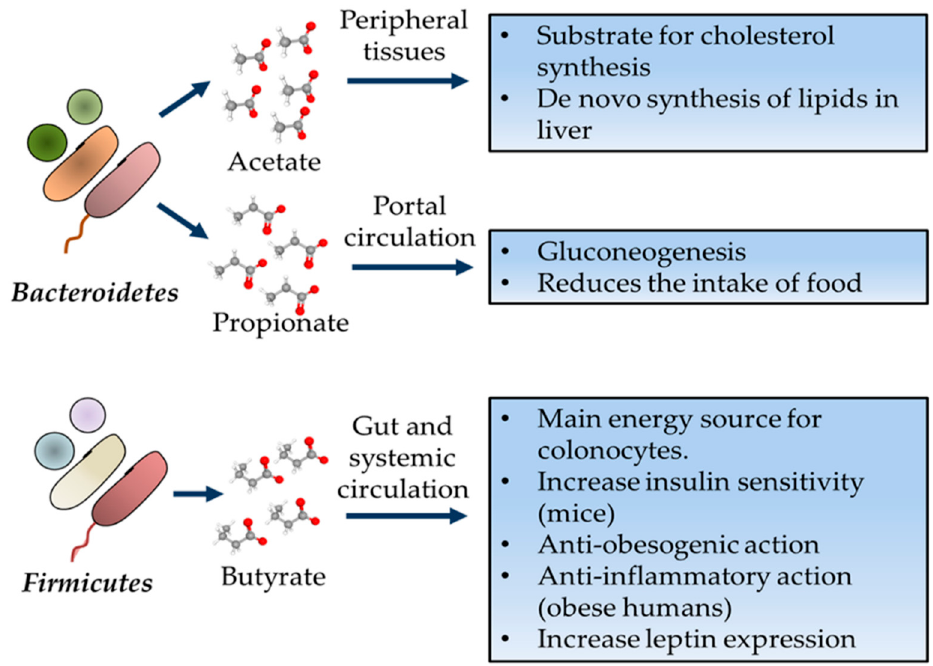
Figure 4. Functions of short-chain fatty acids (SCFAs) in the human body. Acetate, propionate, and butyrate are produced by colon microbiota and have an important paper in human health.